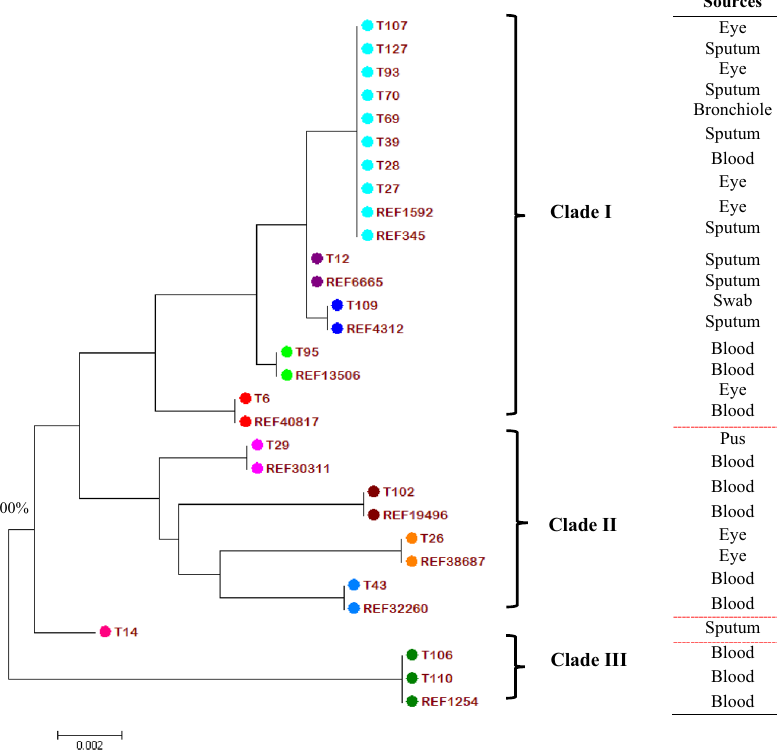
Figure 2. Phylogenetic analysis of the piliated pneumococcal isolates. Phylogenetic analysis revealed three clades among piliated pneumococcal isolates with clade I being predominant and exhibiting mostly serotype 19F of ST236, and all the PI-1 alone and both PI-1+PI-2 isolates. Bootstrap sampling at 1000 replicates showed 100% at all branching. The distribution of sources, sequence type (ST), serotype, pilus genes and multidrug resistance for respective isolates are shown in the right columns. The reference sequences were retrieved from the MLST database comprising identity (ID) numbers 1592 (Taiwan), 345 (Taiwan), 6665 (South Korea), 4312 (Vietnam), 13506 (Malaysia), 40817 (Japan), 30311 (Malawi), 19496 (India), 38687 (China), 32260 (United States) and 1254 (United States); ID number was preceded by REF indicating reference sequence, and ID labelled with T (Terengganu) and numbers represent the isolates in this study. T14 is a newly assigned ST (REF sequence is not